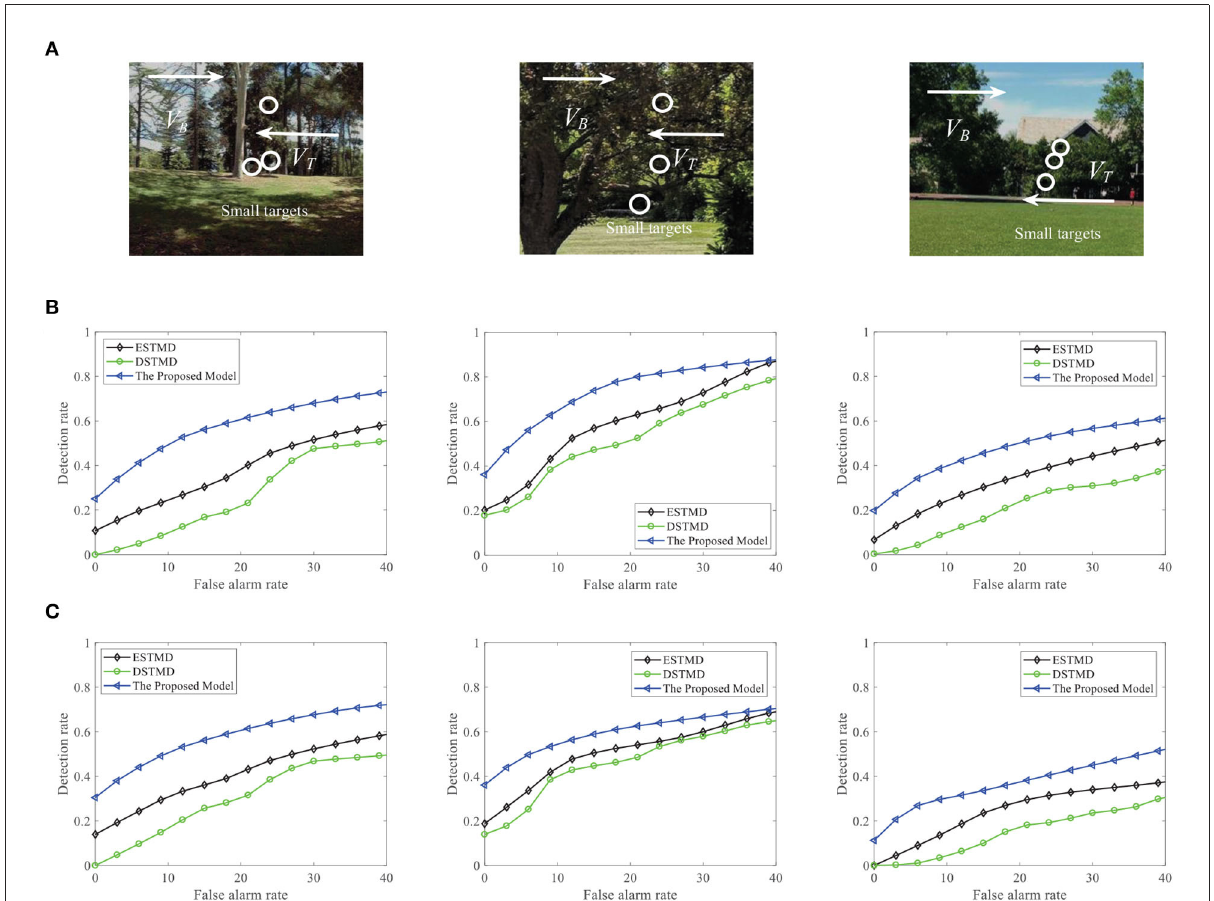
FIGURE13 (A) A frame of the sequence. Small targets are moving against the different cluttered backgrounds. Arrow V B denotes motion direction of the background and V T denotes motion direction of the small target. (B) The D R target. (C) The D R F A curves of the three models for different background with three targets. −